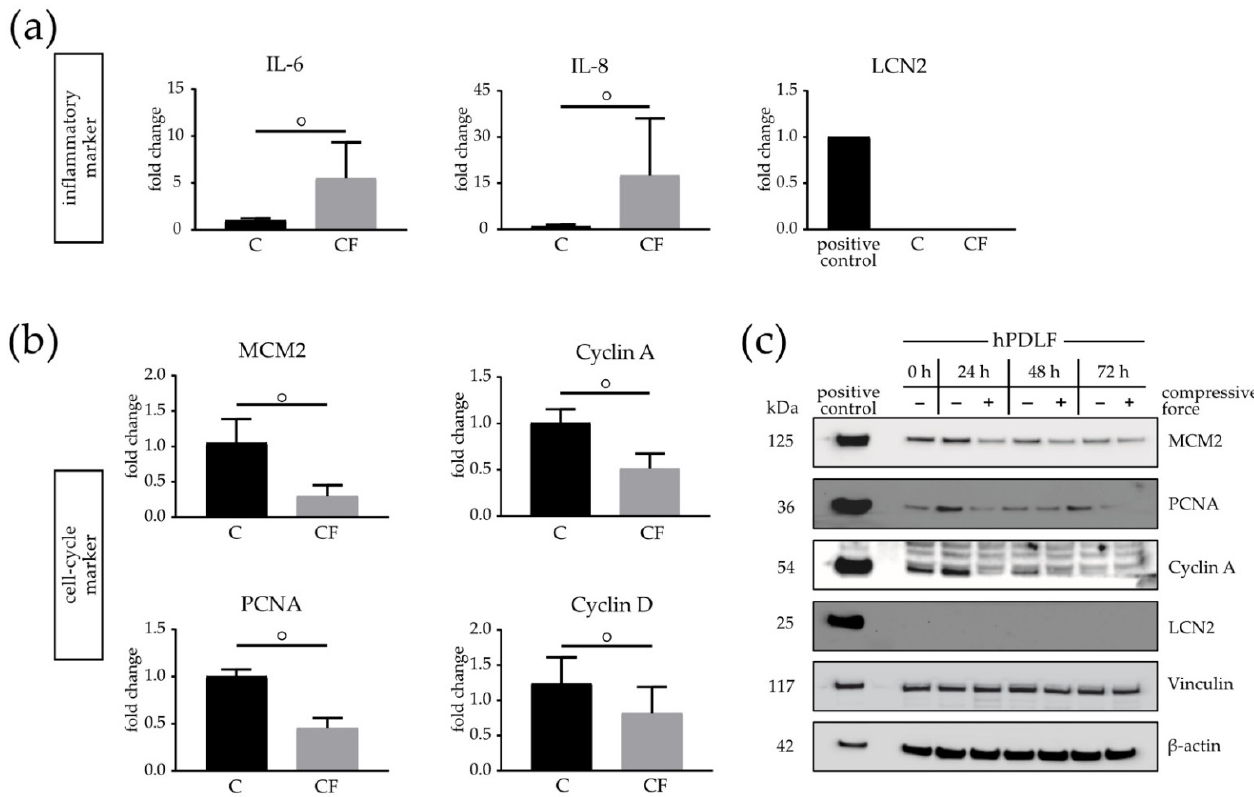
Figure 5. Expression of inflammatory and cell cycle markers in the presence of a compressive force (CF) compared to a control (C) group on the mRNA and protein levels. Real-time (RT) qPCR of IL-6, IL-8 and LCN2 ( a ), as well as MCM2, PCNA and Cyclin A1 ( b ), at 24 h. Cytokines were significantly upregulated in the CF group, whereas inflammatory markers were downregulated at the mRNA level. ( c ) Western blot analysis of hPDLFs from the C and CF groups at 0–72 h for the cell cycle markers (MCM2, PCNA and Cyclin A1) and inflammatory marker LCN2. β -actin and Vinculin were used as the endogenous controls. Human PC-3 cells were used as the positive control. Bars indicate the mean values ± standard deviation. A p -value < 0.05 was considered statistically significant. (°) Comparison of the CF with the respective controls of the time point.